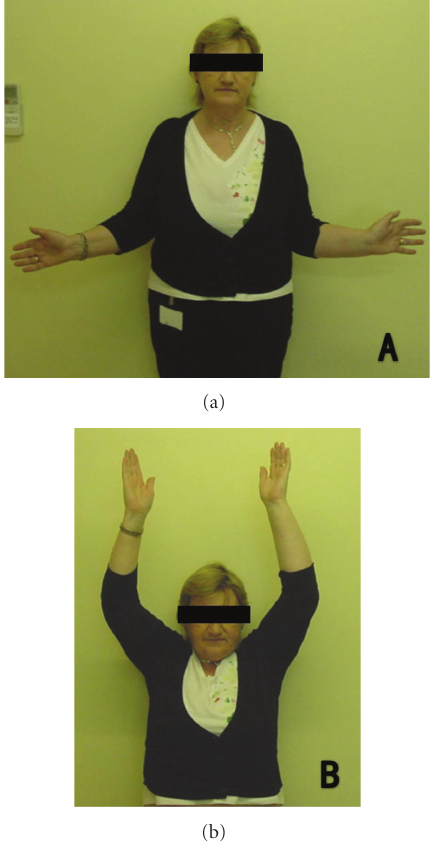
Figure 4: Photographs demonstrating active range of motion at two years